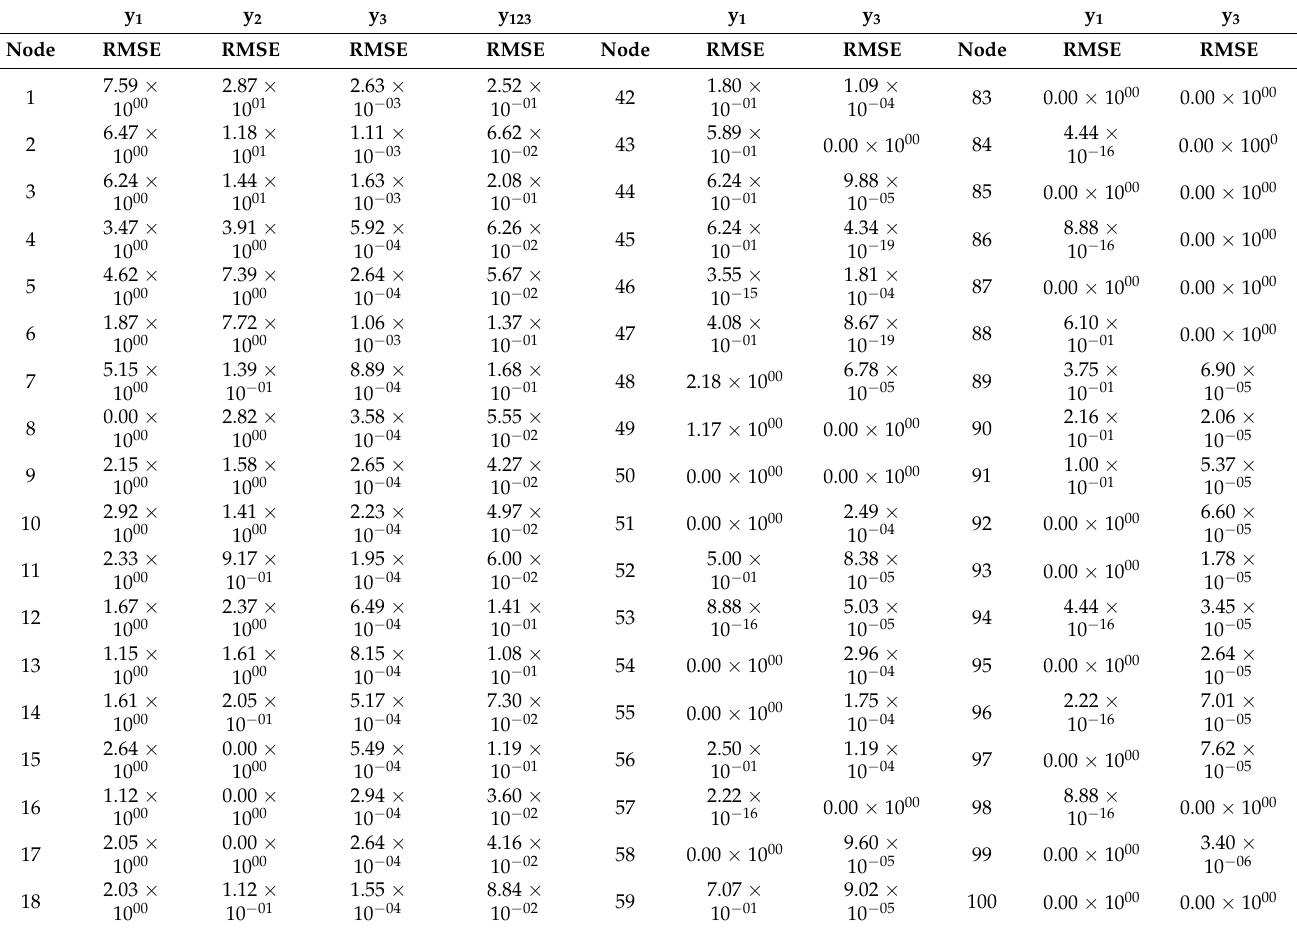
Table A2. The RMSE values for each split in regression trees for y 1 , y 2 , y 3 and y 123 . The nodes are numbered from the top of the tree down and from the left to the right at each tree